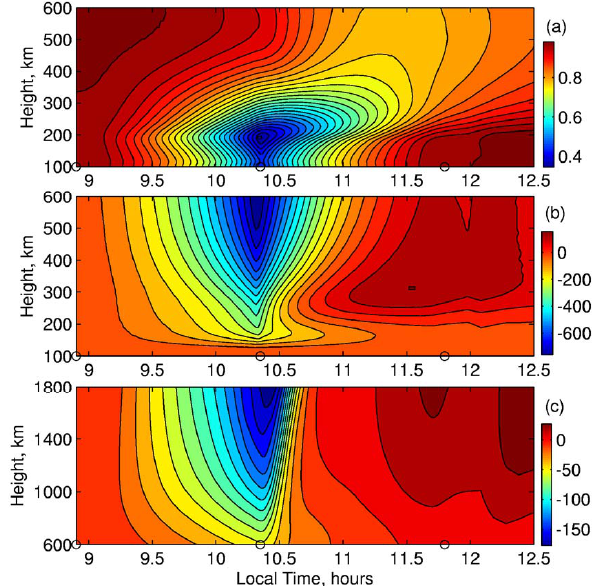
Figure 6. The simulated ionospheric response to the solar eclipse at latitude of 48.8° N. Time evolution of the relative change in electron density (a), Ne E /Ne C , electron temperature (b), Te E – Te C , and ion O + drift velocity along field line (positive upward) (c), ViO E – ViO C . Circles on the x-axis indicate the time of the commencement, totality and end of solar eclipse, respectively.